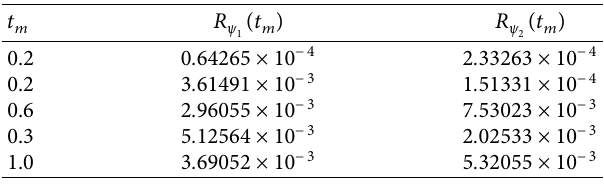
( t ) and ψ 1 ( t ) and R ( t ) for example 1. m m ψ 1 ψ 2